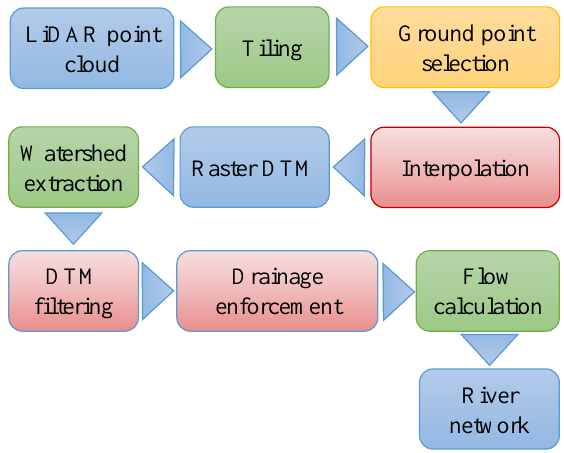
Figure 1: River network extraction through DTM interpolation and flow